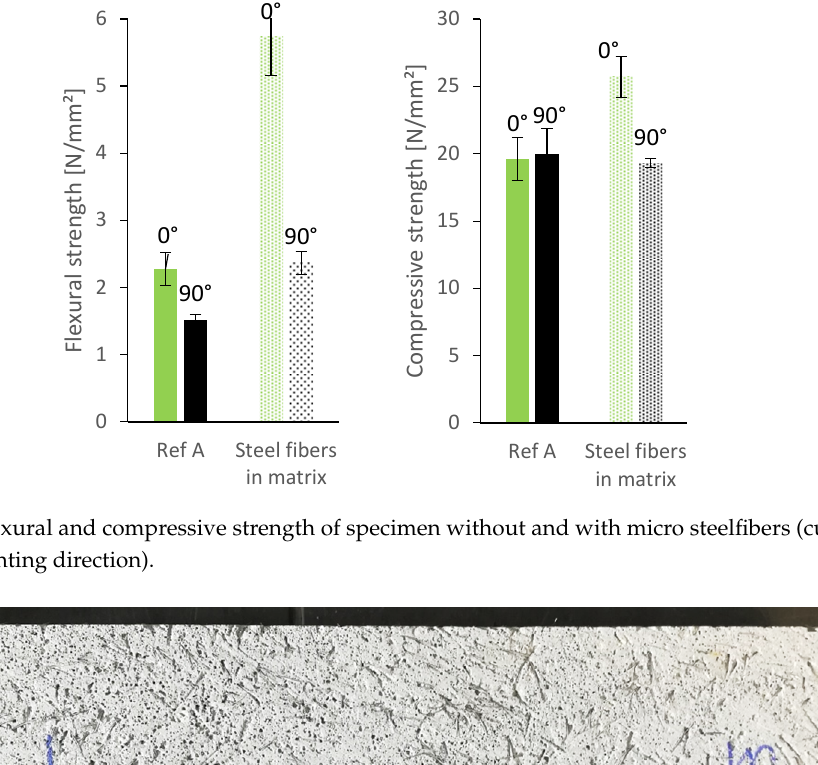
Figure 8. Micro steelfiber orientation in a prism sawn out from a 3D-printed object (side view).